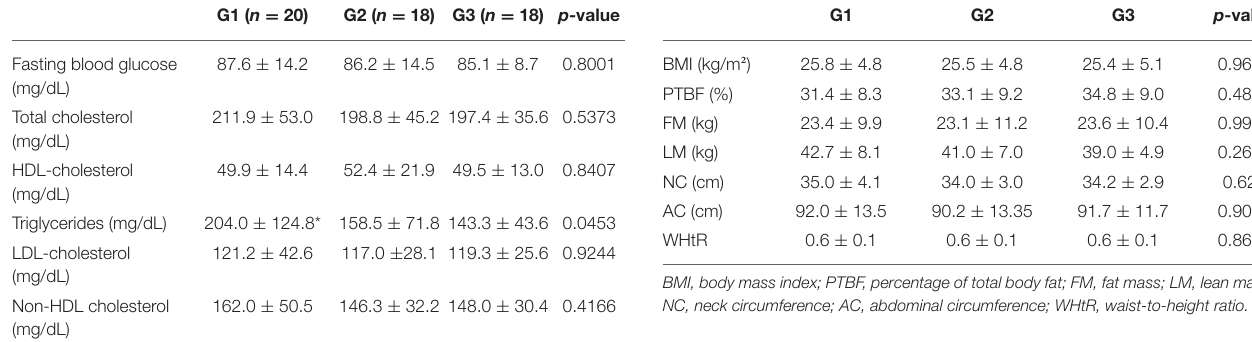
TABLE 3 | Body composition of women stratified by group of people living with TABLE 1 | Metabolic profile of women stratified by group of people living with HIV/AIDS with (G1) and without HALS (G2) and control group (G3). HIV/AIDS with (G1) and without HALS (G2) and control group (G3). G1 ( n = 20) G2 ( n = 18) G3 ( n = 18) p -value